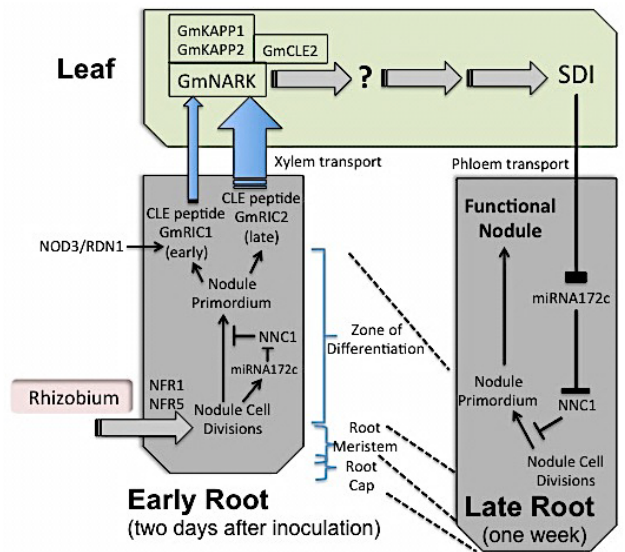
Figure 2. Systemic regulation of nodulation in legumes. Formation of nodule primordia (requiring NF perception as shown in Figure 1) initiates the production of miRNA172, which targets AP2 transcription factor type GmNCC1 (Nodule Number Control 1, which blocks further nodule development). Also induced are rhizobia-induced CLE peptides (such as GmRIC1 and GmRIC2 in soybean), with subsequent xylem transport to the leaves, where they act as ligands for a LRR receptor kinase (LRR-RK) like GmNARK, MtSUNN, or LjHAR1. Perception of the ligand allows for the phosphorylation of the kinase domain of the LRR receptor. KAPP1 and KAPP2 are transphosphorylated. A shoot-derived inhibitor (SDI) molecule is produced following the perception of the peptide signal by NARK, which is then transported to the roots (possibly via the phloem) where it inhibits miRNA172 , thus leading to increased GmNNC1 and resultant nodule inhibition [33]. In GmNARK -deficient mutants, no degradation of the miRNA occurs, leading to continued GmNNC1 degradation and nodule development. Note, NOD3 and RDN1 genes of P. sativum and M. truncatula have high similarity to peptide glycosylating genes of Arabidopsis , perhaps essential for arabinose addition to the 13 amino acid long CLE peptide. Mutations in NOD3 and RDN1 lead to super- or hypernodulation controlled by the root genotype, in contrast to mutants in GmNARK , MtSUNN or LjHAR1 , which are